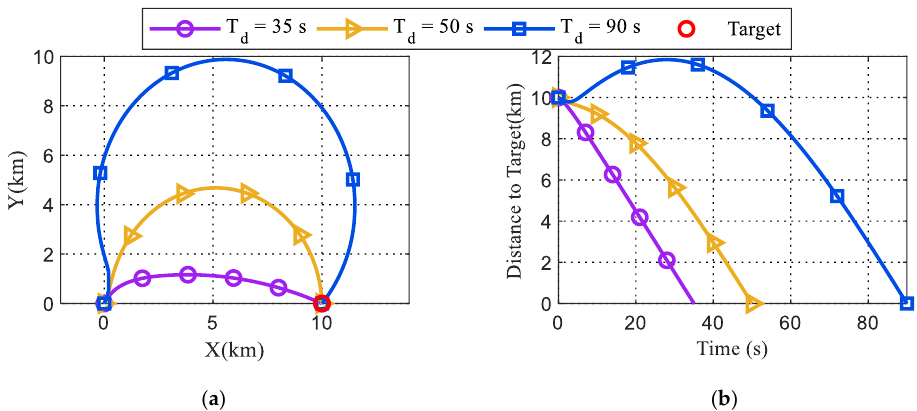
Figure 3. The results without look angle constraint. ( a ) Trajectories; ( b ) Distance to target.